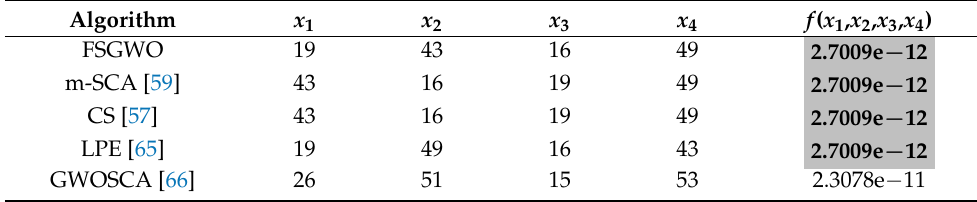
Table 16. Results of related algorithms for the gear train design problem.